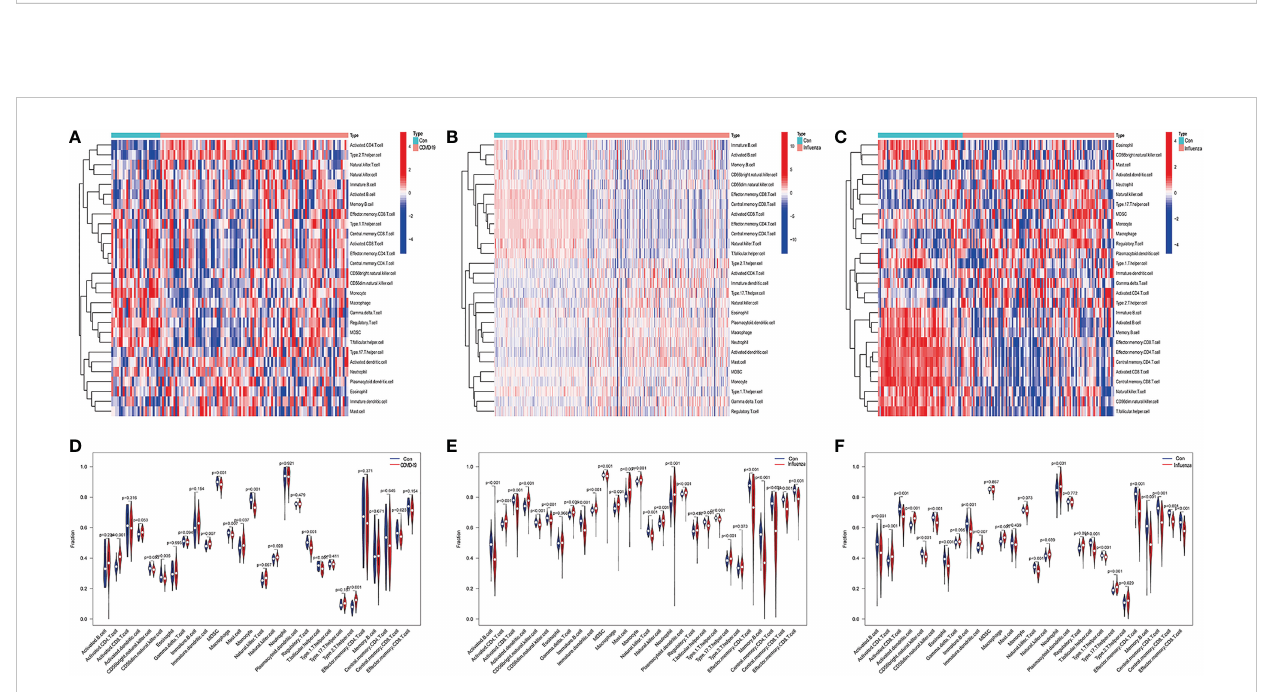
FIGURE 10 (A) Heatmap of in fi ltrated immune cells in COVID-19, (B) Heatmap of in fi ltrated immune cells in H1N1, (C) Heatmap of in fi ltrated immune cells in In fl uenza. (D) Fraction of in fi ltrated immune cells in COVID-19, (E) Fraction of in fi ltrated immune cells in H1N1, (F) Fraction of in fi ltrated immune cells in In fl uenza.